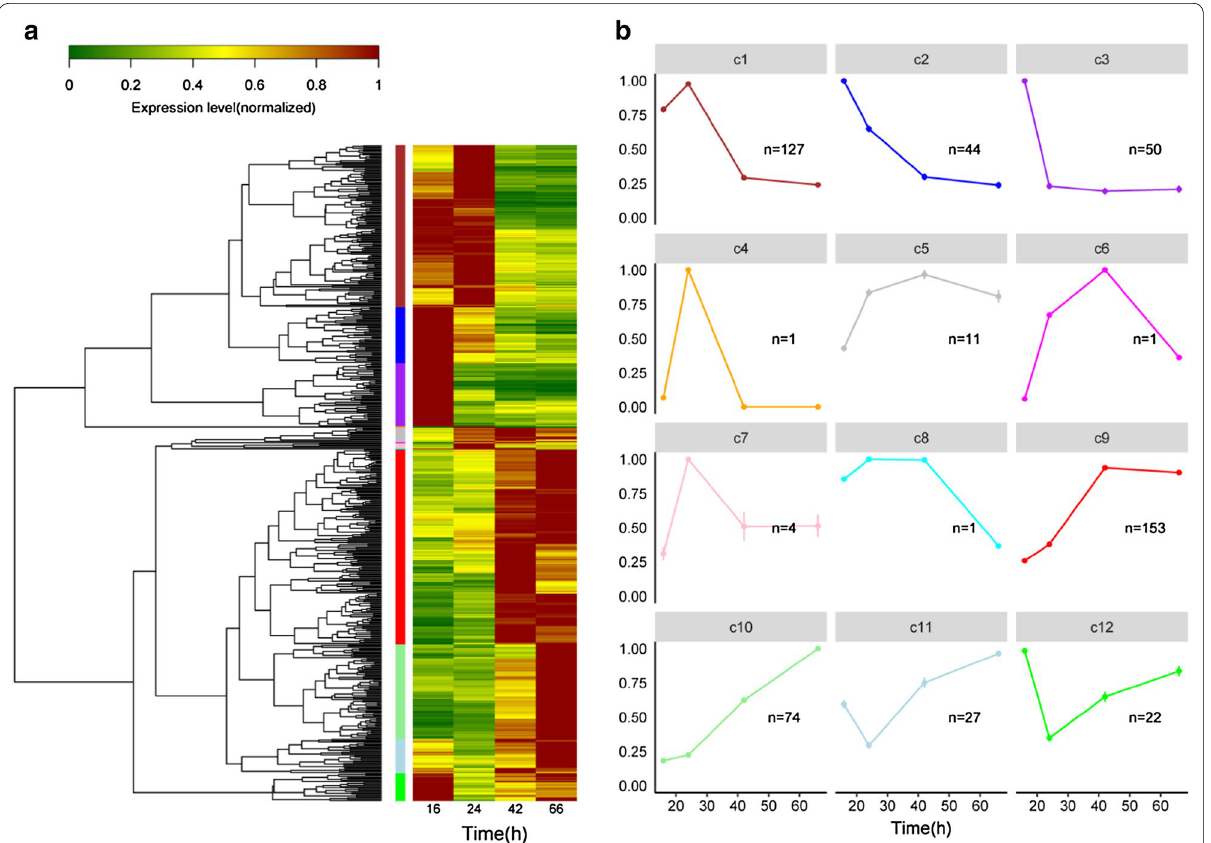
Fig. 3 Hierarchical clustering analysis of 515 selected genes expression during glucoamylase fermentation. a Each horizontal line displays the expression data for one gene after normalization (the mean of FPKM value at one time point divided through the maximum of mean FPKM value for each gene) at time points as indicated. The color scale at the top left represents the normalized expression level (0–1). The highest expression of each gene is therefore defined as 1 ( dark red color ). Color bars in the middle indicate defined sub‑branches according to the height of the tree. The genes assigned to each cluster are listed in Table c1 – c12 . b Gene expression profiles analysis. c1 to c12 represent the twelve clusters indicated orderly by the color bars in Fig. 3a. Mean and standard error of the normalized expression data of genes in each cluster at the four time points were used to plot the curves. The number of genes found in each cluster is indicated by the value of